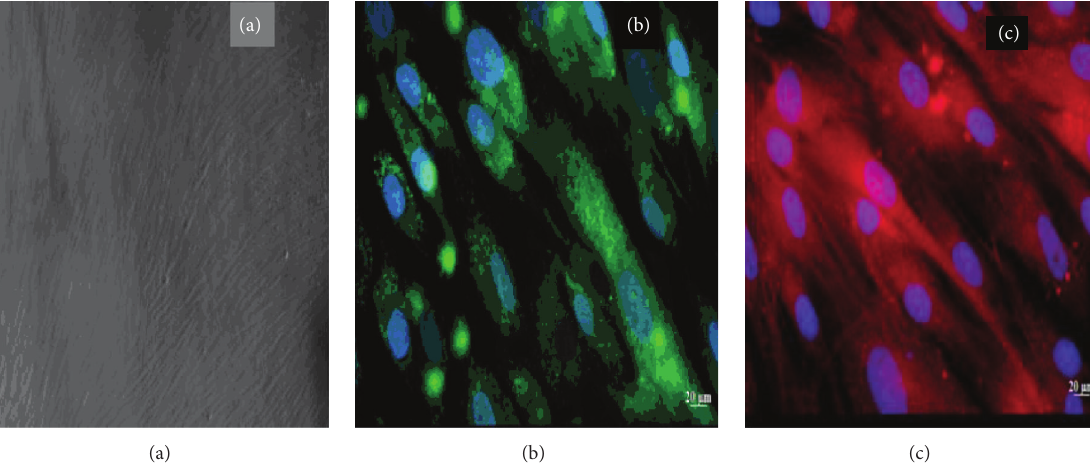
Figure 2: (a) Spindle-shaped morphology of rabbit adipose MSCs. (b) Staining of CD+ 90, specific cell surface marker. (c) Actin staining showing cytoskeletal